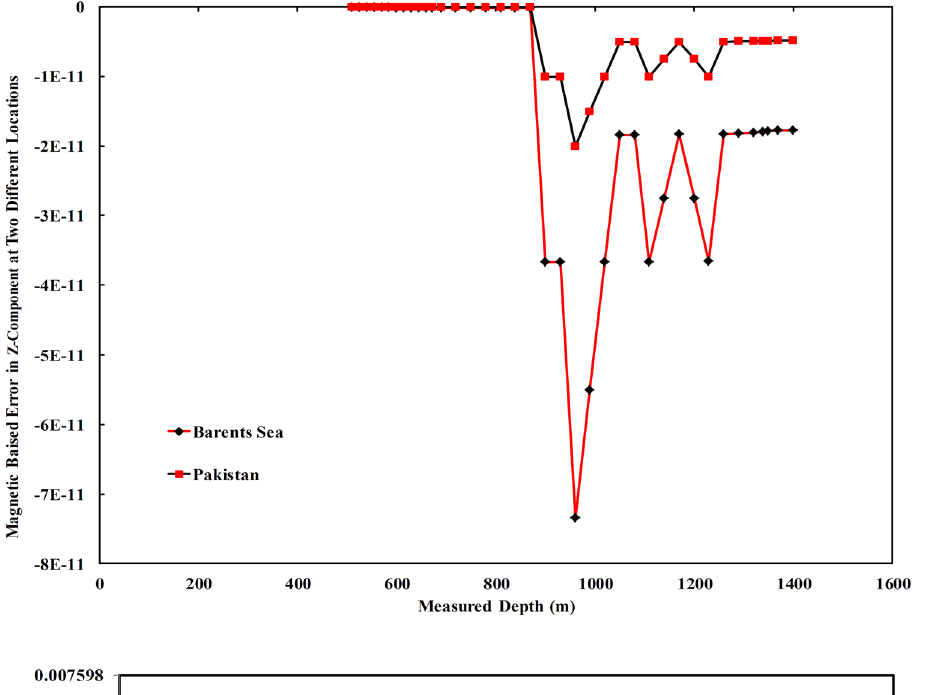
Fig. 8 Error in magnetometer X -component for Barents